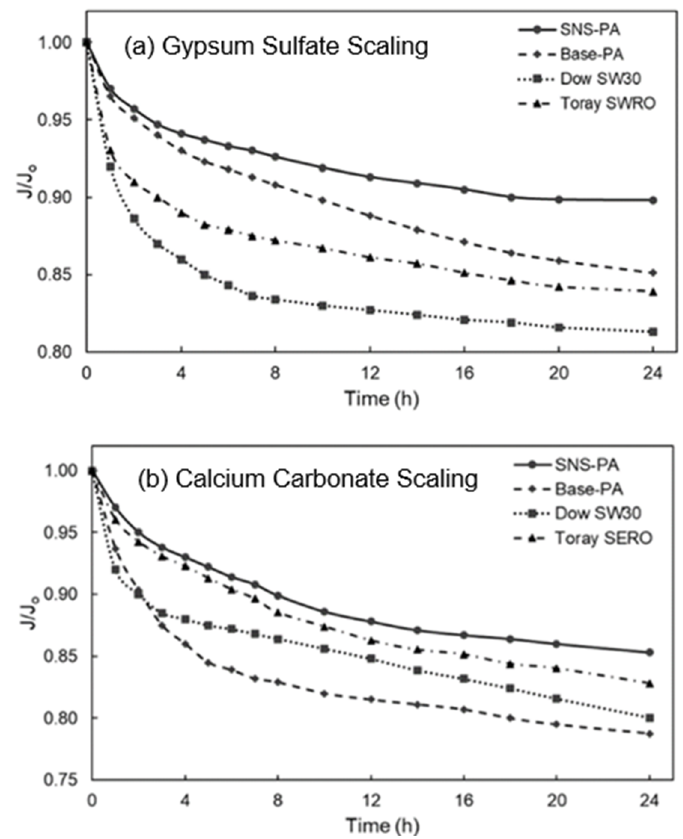
Figure 1. Flux decline for the SNS-PAA-PA membrane after 24 h calcium sulfate scaling ( a ) and calcium carbonate scaling ( b ) tests, also showing the corresponding flux decline curves for the commercial SW30, Toray SWRO, and base-PA membranes. (Scaling tests conditions: Calcium sulfate feed solution pH of 5.7, membrane surface saturation index of gypsum SI g = 1.7; calcium carbonate feed solution pH of 7.9, membrane surface saturation index of calcite SI c = 10.6.)